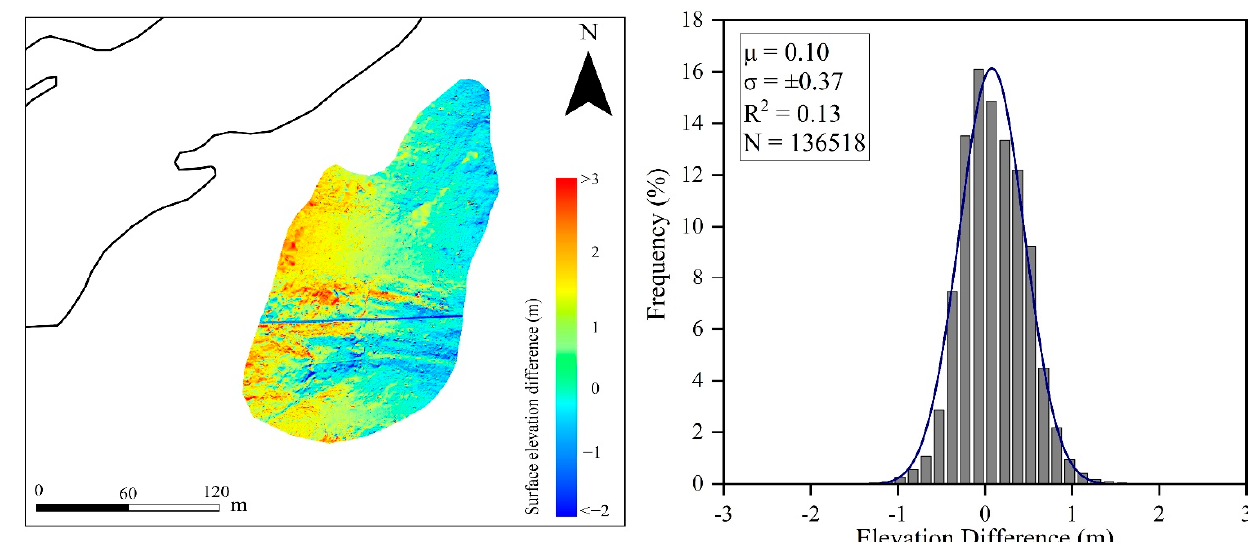
Figure 9. Left : the spatial distribution of elevation changes in non ‐ glacial areas; Right : the frequency distribution corresponding to the left, along with the mean ( μ ), the standard deviation ( σ ), variance (R 2 ), and the number of pixels (N).